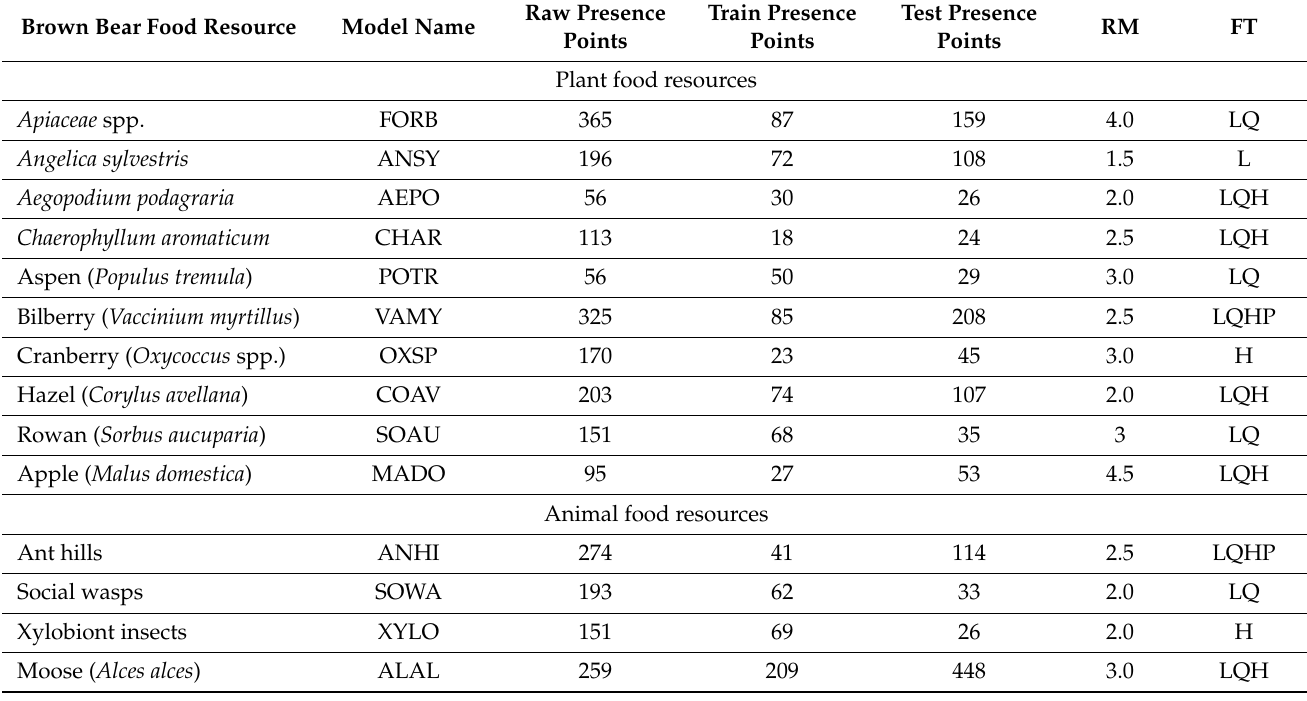
Table 2. The input data, regularization multiplier (RM), and feature types (FT) for 14 brown bear food- probability models in the Central Forest State Nature Reserve (West-European Russia) in 2008–2020. Feature types shown are linear (L), quadratic (Q), product (P), and hinge